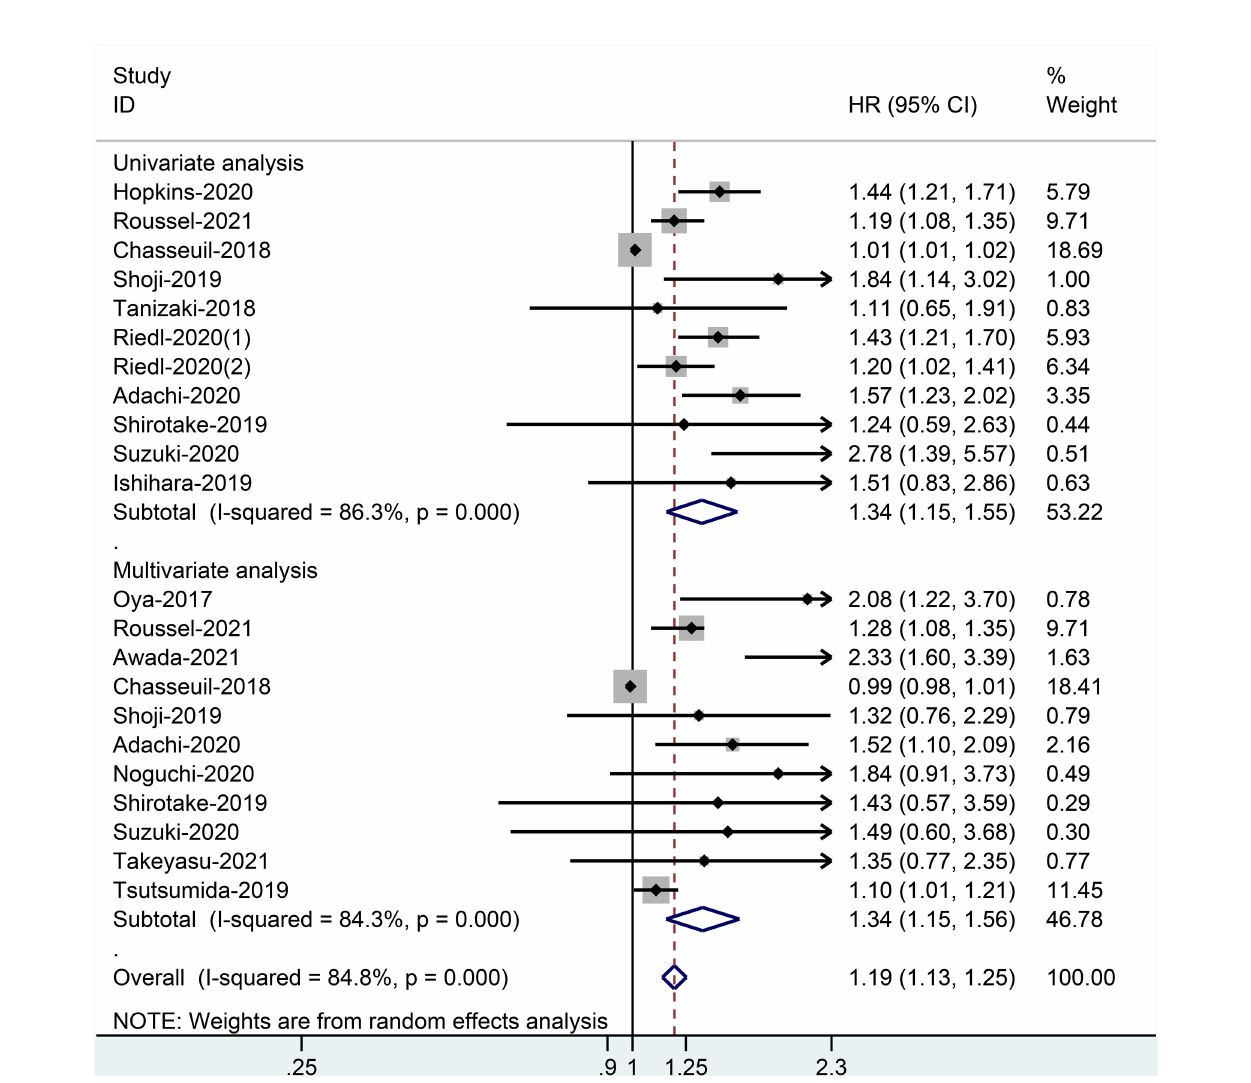
FIGURE 5 | Forest plot of pooled HR and 95% CI about the relationship of baseline CRP levels and PFS categorized by univariate and multivariate analysis outcomes in cancer patients treated